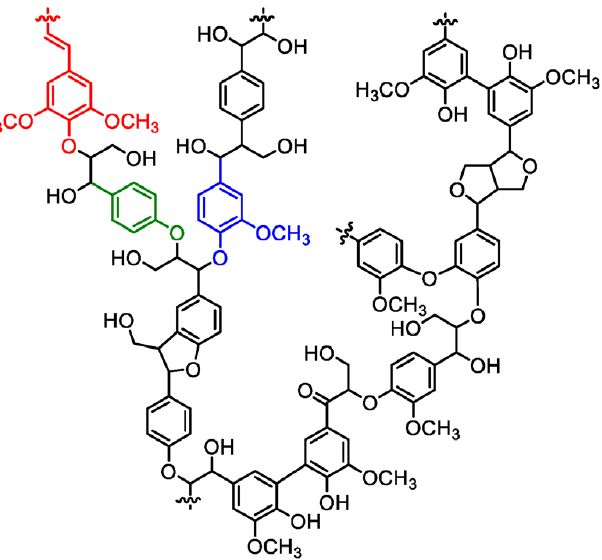
Figure 1. Chemical structures of the primary lignin precursors (a) and the hydroxycinnamates (b) R = H. Adapted from